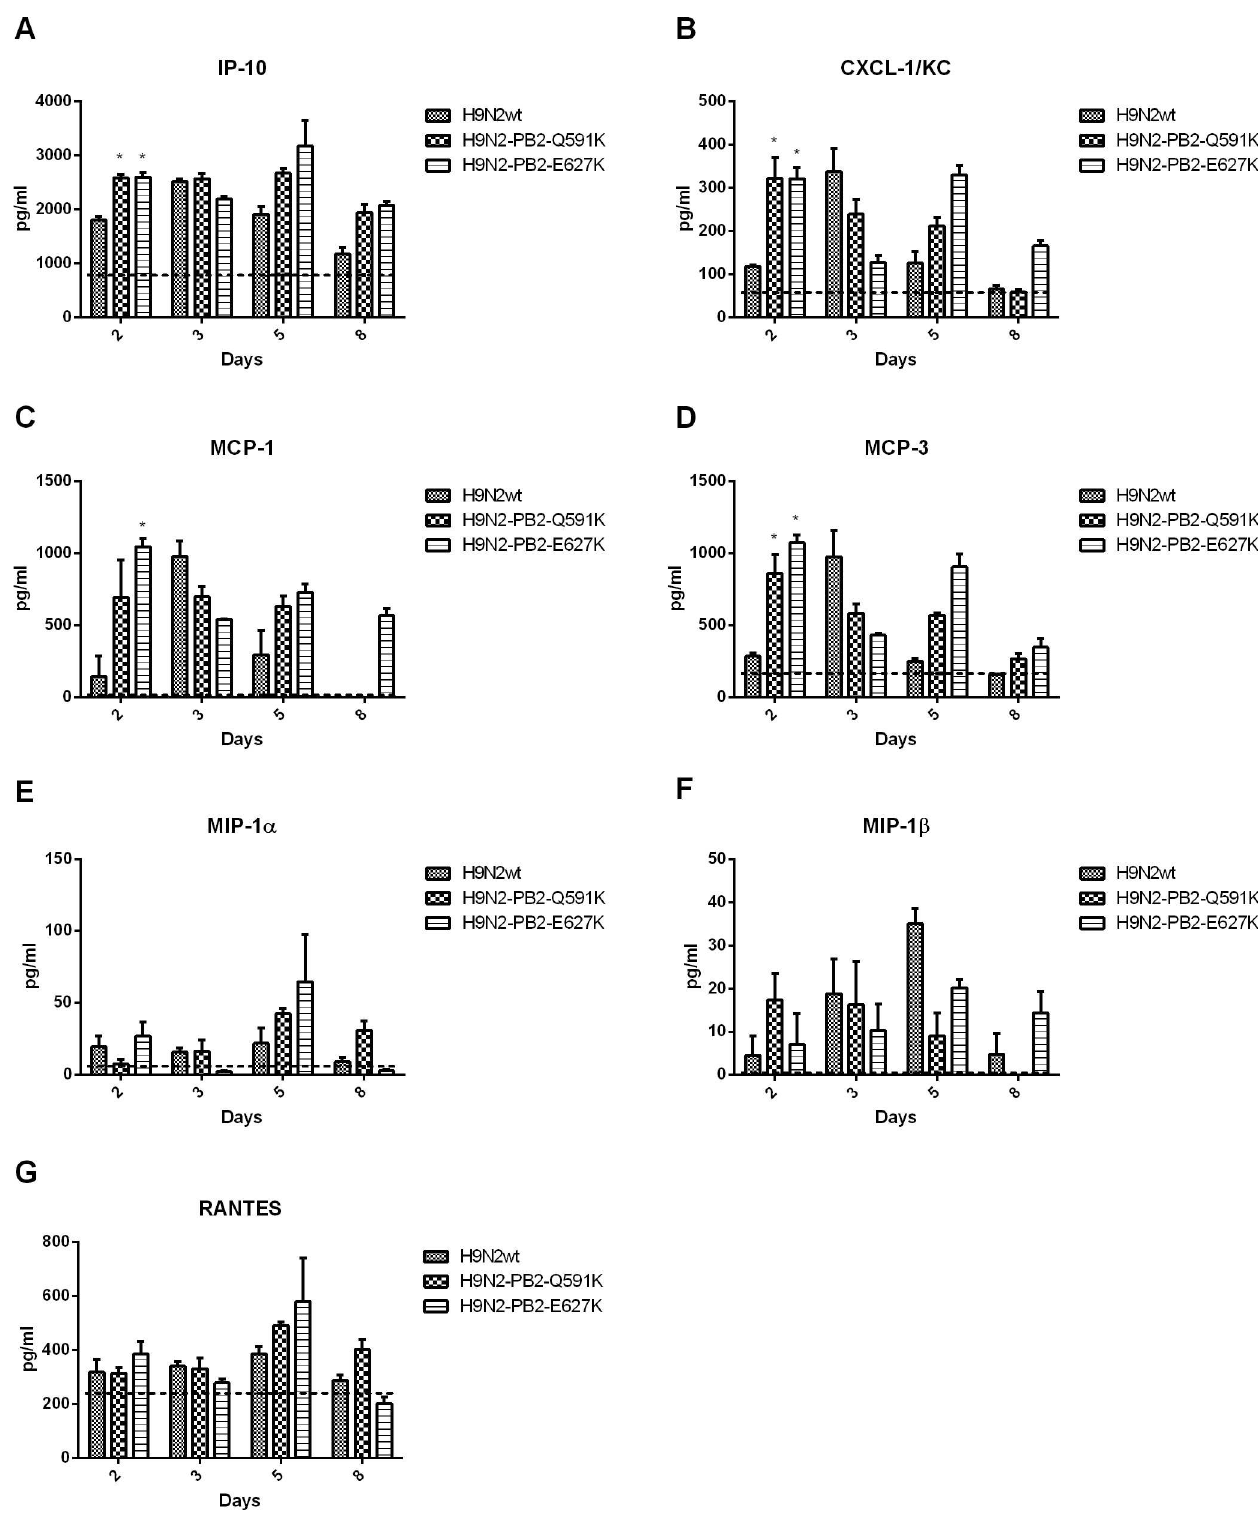
Fig 6. Cytokine responses in the serum of H9N2/G1 virus infected mice. Cytokine (IP-10, KC, MCP-1, MCP-3, MIP1-a, MIP-1b and RANTES) levels from the serum of infected mice were collected from days 3 and 6 post-inoculation and measured individually by the FlowCytomix system. Results from each time point are expressed as means of three infected mice (n = 3) and are the representative results from one of two independent experiments. Dot lines represent the level of mock. * :p < 0.05